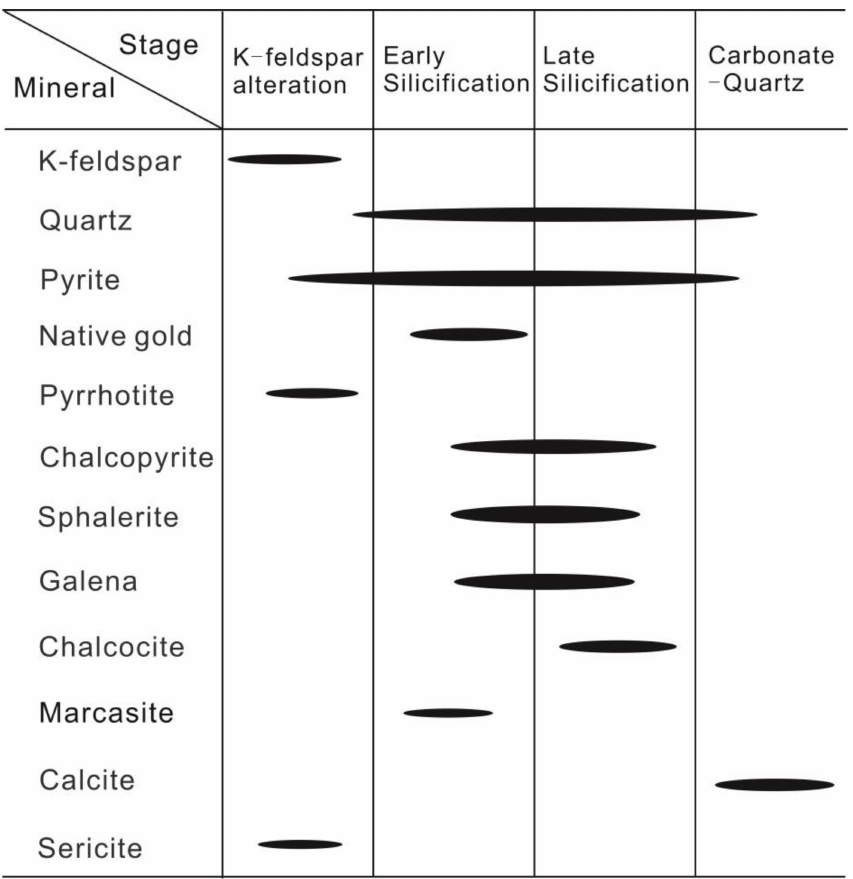
Figure 8. Paragenetic sequence of gold mineralization and alteration of the Baiyun gold